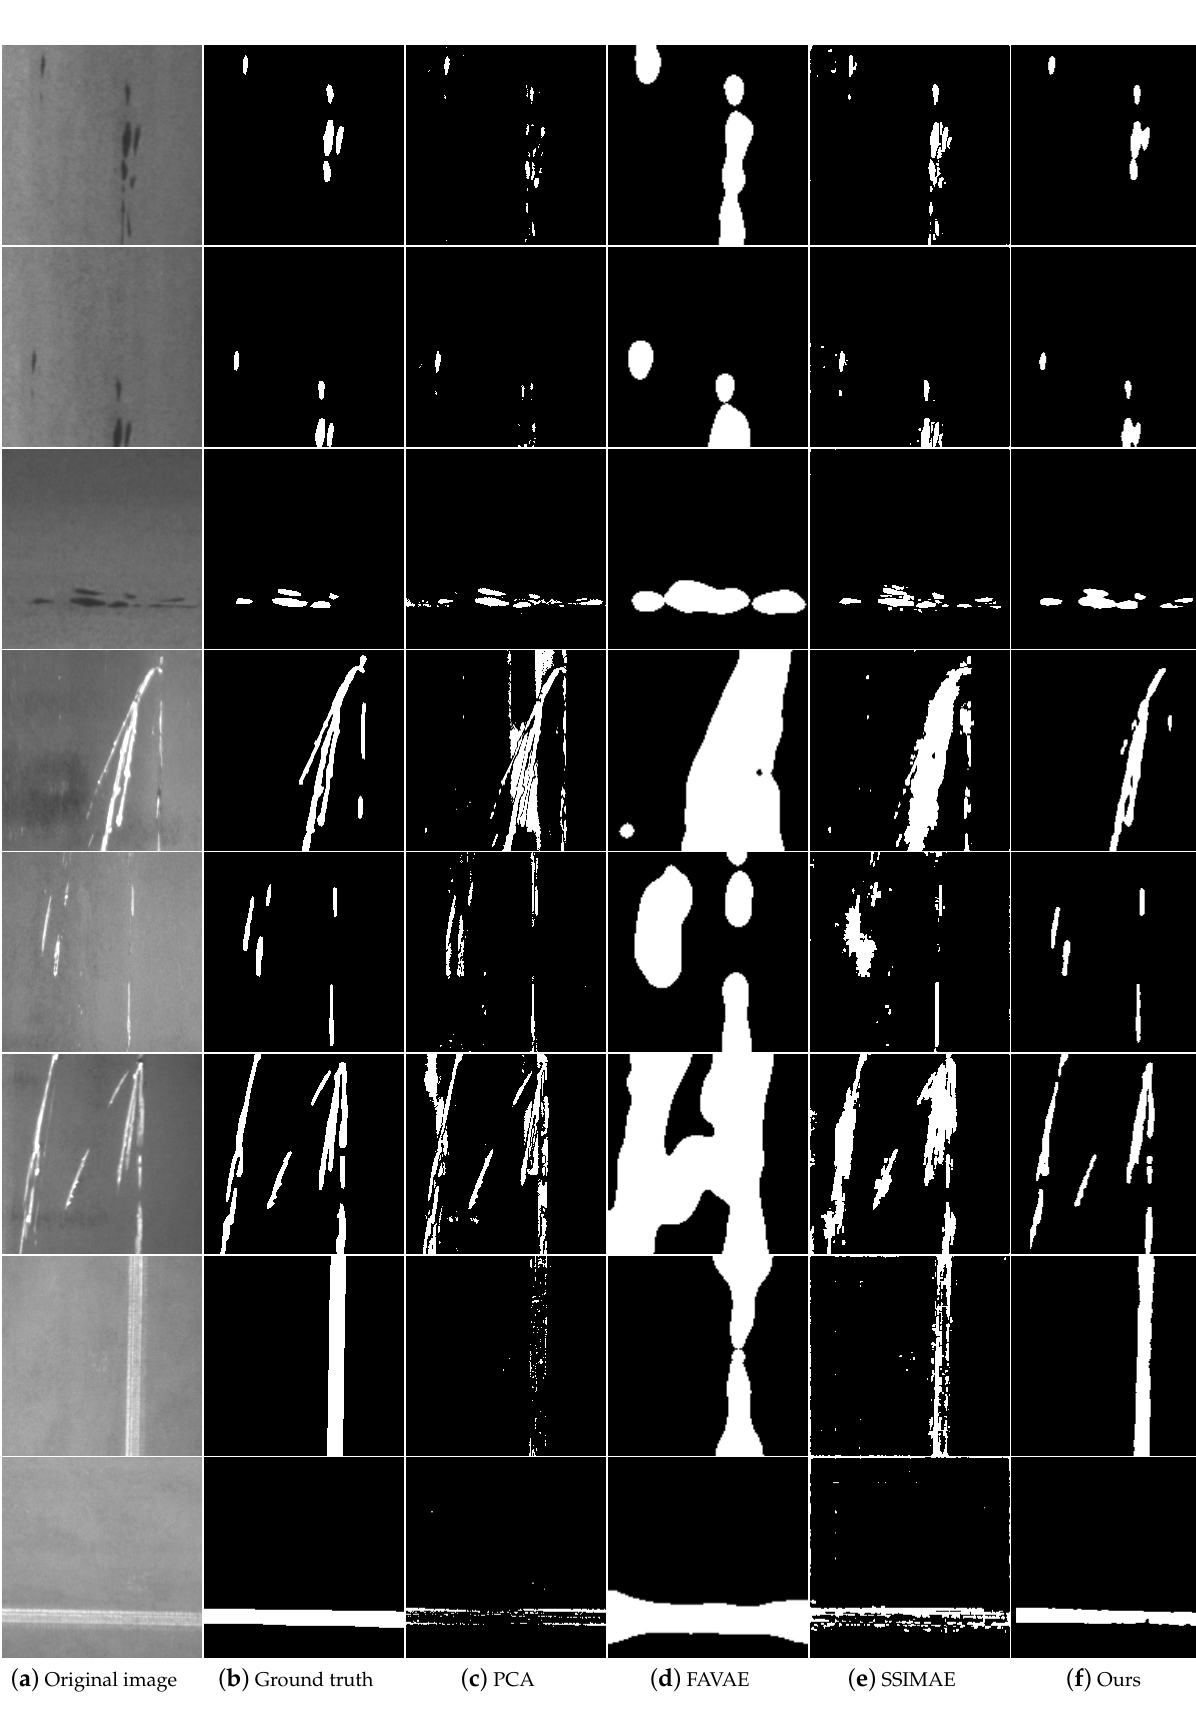
Figure 4. The results of different approaches on